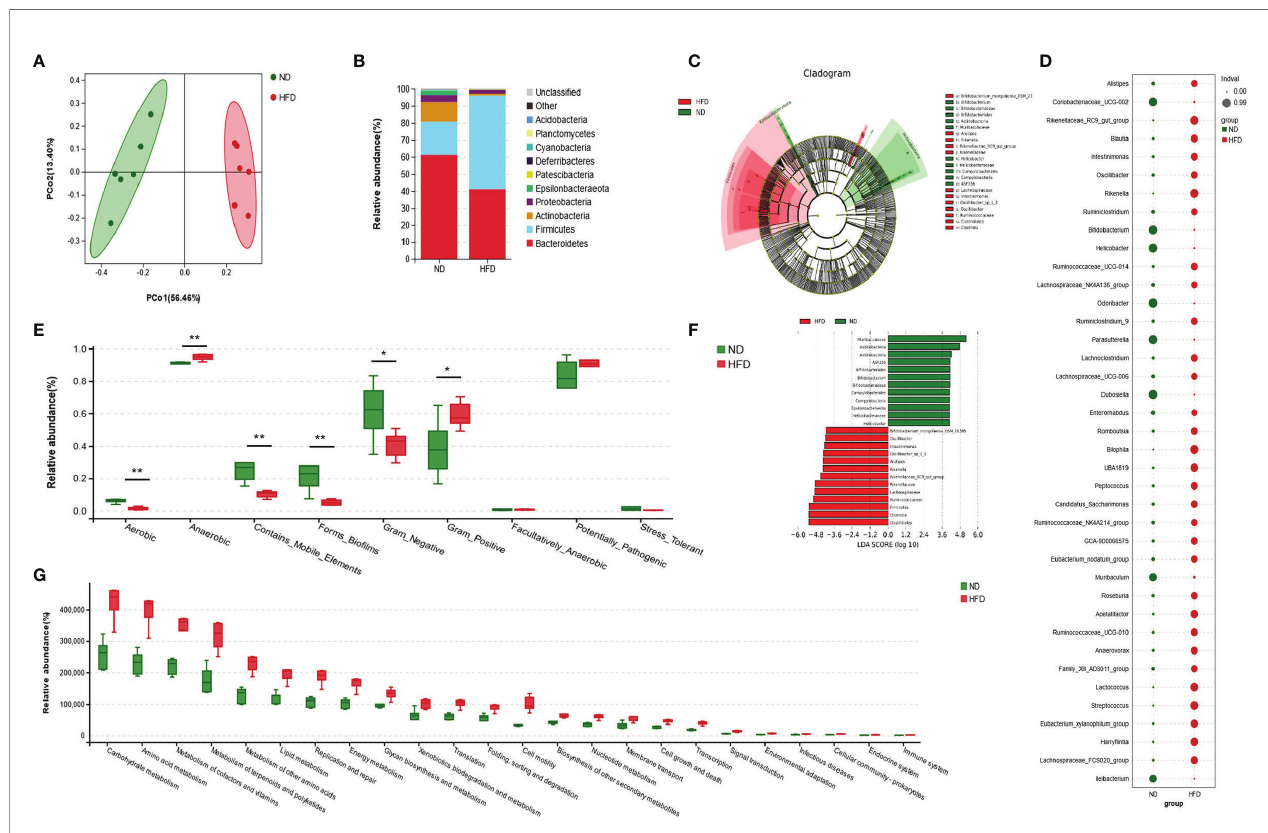
FIGURE 3 | High-fat diet altered the composition and function of gut microbiota. (A) Principal coordinate analysis (PCoA) of gut microbiota (GM) in ND-fed and HFD- fed mice (n = 6). (B) The relative abundance of GM at the phylum-level in both groups (n = 6). (C, F) Cladogram showing the most differentially abundant taxa identi fi ed by linear discriminant analysis effect size (LEfSe). Red indicates clades enriched in the HFD group, and green indicates clades enriched in the ND group. Genera meeting a linear discriminant analysis (LDA) score threshold > 4 are shown in Figure 3F (n = 6). (D) Indicator analysis through calculating indicator value (IndVal). The greater the IndVal, the more likely the genus is to become the indicator for the group (n = 6). (E) Bugbase prediction of GM phenotypes for both groups (n = 6), * P < 0.05, ** P < 0.01. (F) Functional enrichment analysis of GM based Kyoto Encyclopedia of Genes and Genomes (KEGG) pathway. The KEGG pathways of level 2 ( P <0.05) are listed (n =